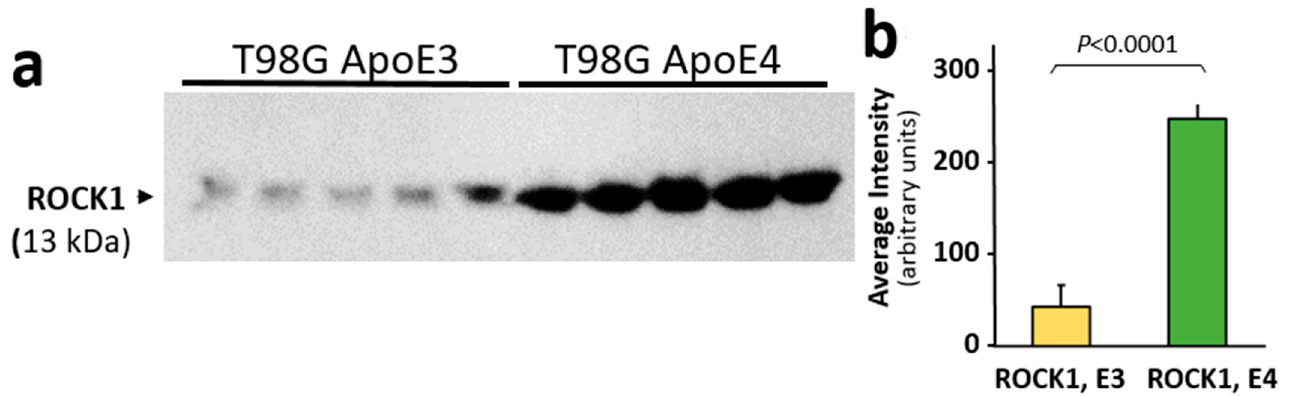
Figure 4. ROCK1 protein levels are higher in T98G glioblastoma cells overexpressing an ApoE4 transgene than in T98G cells overexpressing ApoE3. ( a ) Western blot probed with antibody to ROCK1 protein. ( b ) Mean ± SEM of Western blot band intensity for independent T98G cell cultures (each N = 5). The difference between ROCK1 (E3) and ROCK1 (E4) is significant according to heteroscedastic, two ‐ tailed t ‐ test at p ≤ 0.0001.